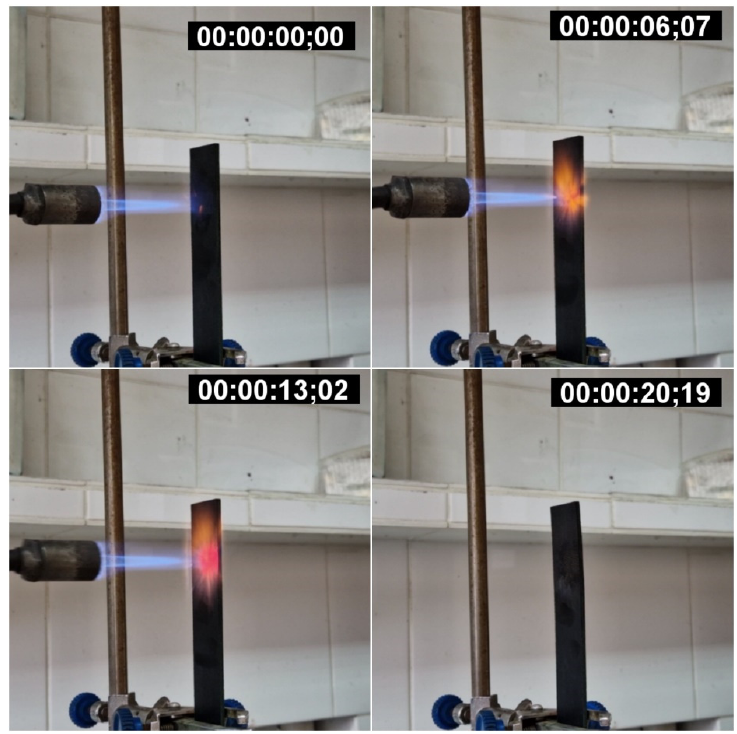
Figure 9. GFRP burning at 1300 °C for 13